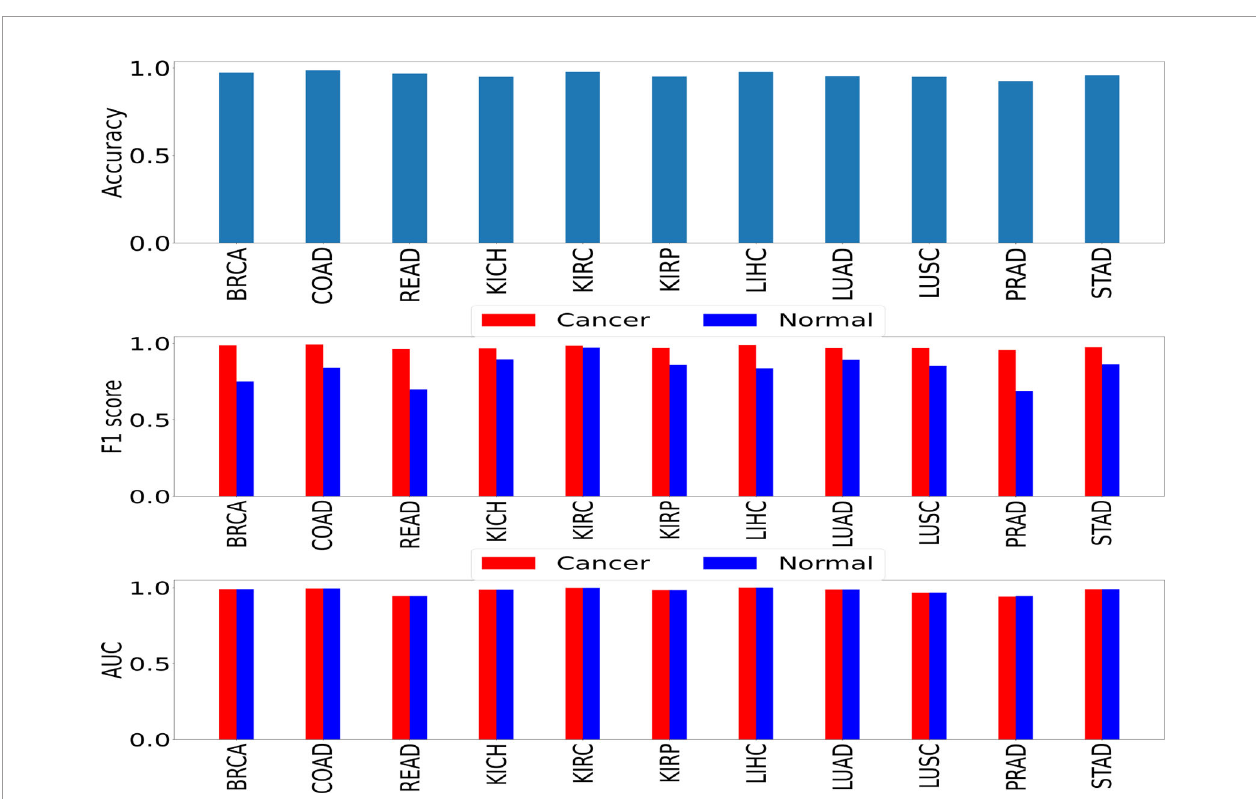
FIGURE 4 | Self-organ inference showing the performance obtained using models trained on each cancer and tested on a held-out test set of the same